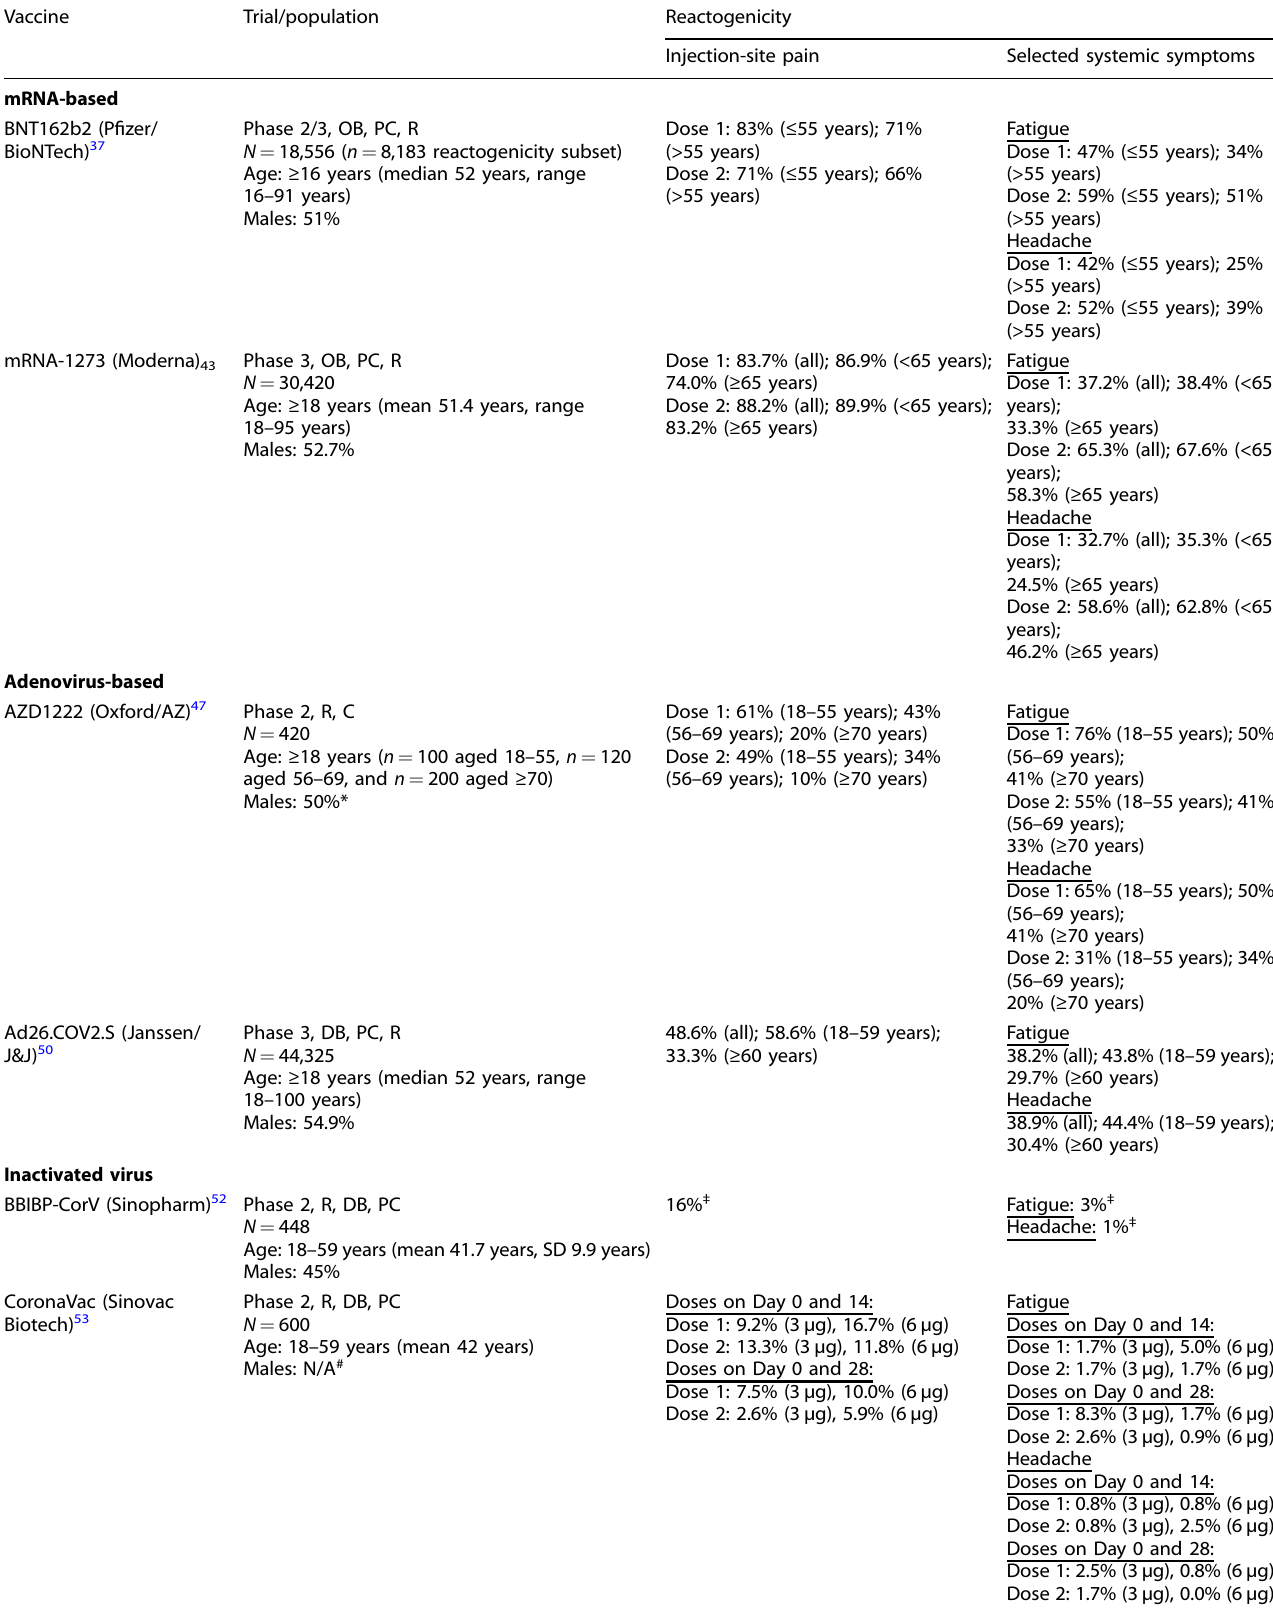
Table 2. Reactogenicity of COVID-19 vaccines approved by WHO for emergency